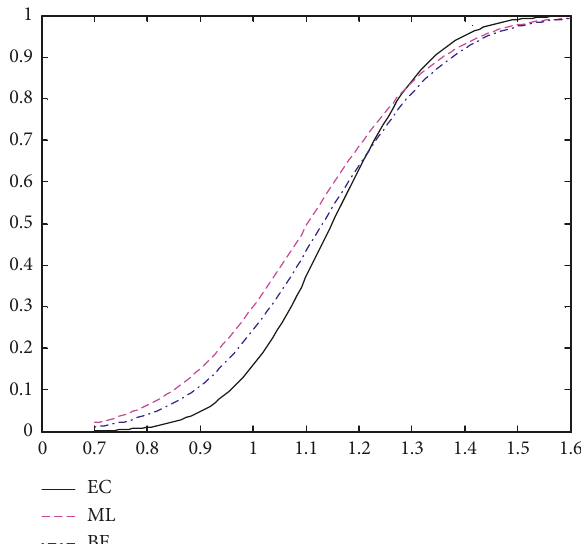
Figure 1: The cumulative distribution function curves according to different parameter estimation methods for the drilled pile foundation (note: the horizontal ordinate is the random variable, and the longitudinal coordinate is the cumulative distribution